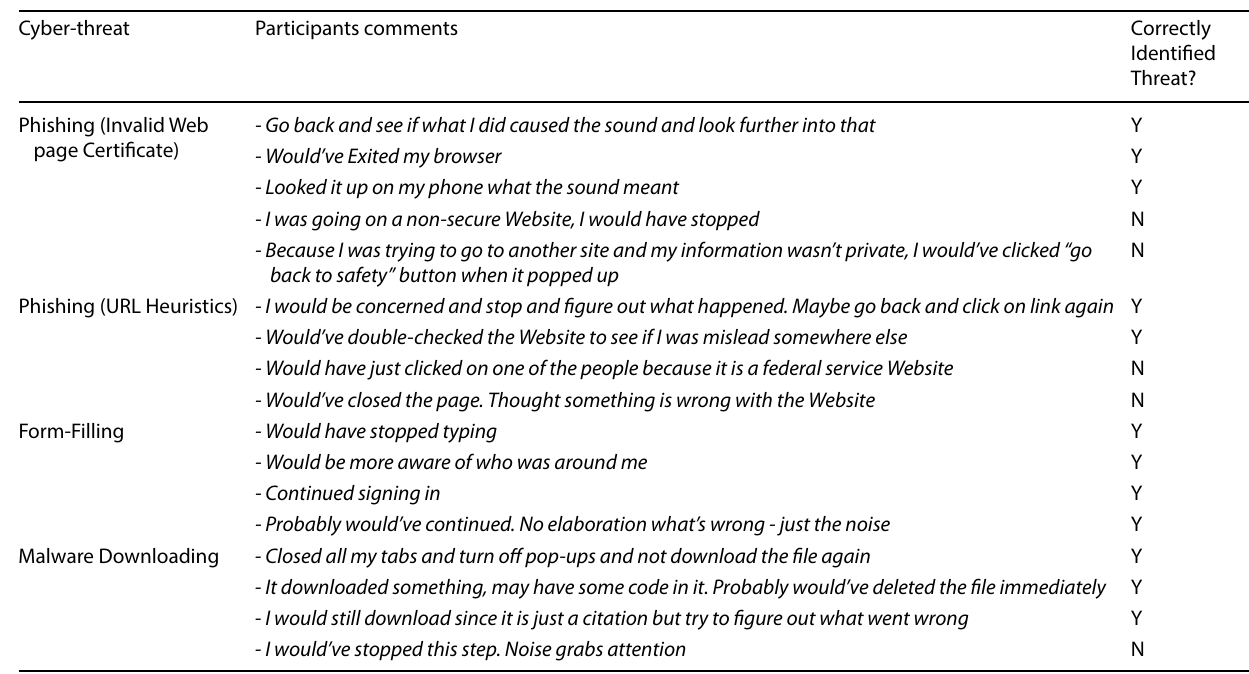
Table 7 Participants responses for the “In-context